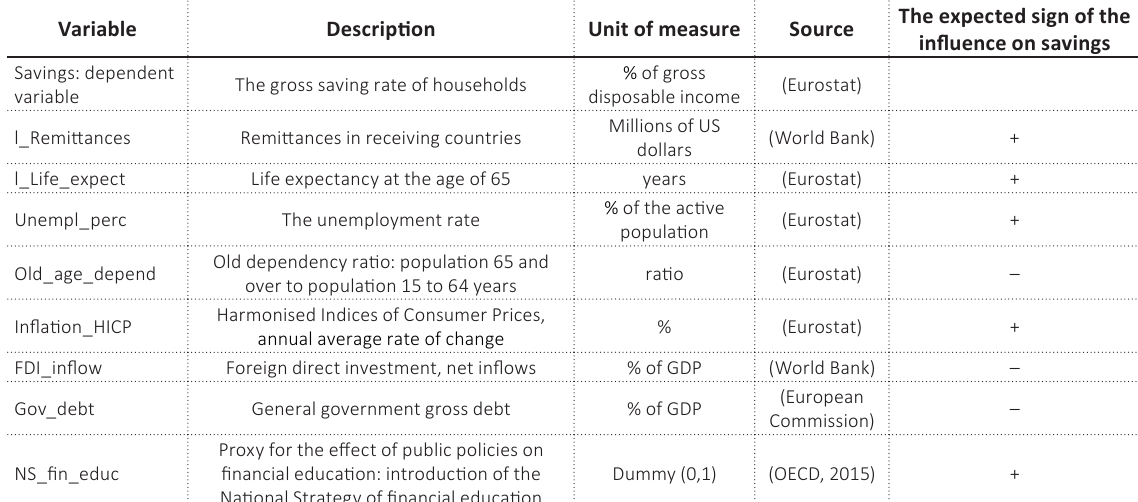
Table 1. Description of variables